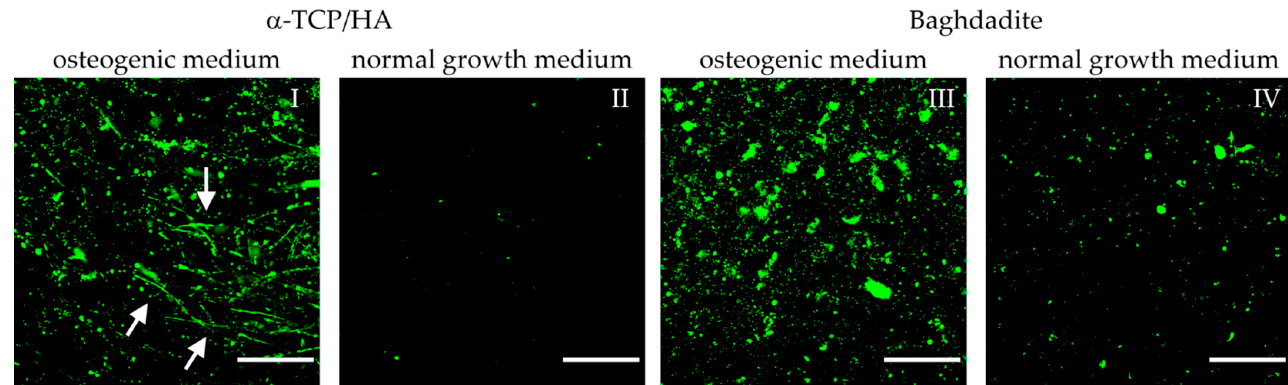
Figure 8. Multiphoton microscopy images of MC3T3-E1 cells seeded on α -TCP/HA and baghdadite scaffolds. Scaffolds were initially cultivated in normal growth medium for four weeks. Subsequently, transfer to and cultivation in osteogenic medium ( I , III ) occurred for additional three weeks (references ( II , IV ): scaffolds remaining in normal growth medium). Fluorescence labeling of hydroxyapatite (green) with OsteoImage mineralization assay exemplifies the mineralization of the collagen-I matrix. Images were processed from the sum intensity of a series of 10 equidistant images ( ∆ = 5 µm, depth: 45 µm) followed by background subtraction. Scale bars: 50 µm.